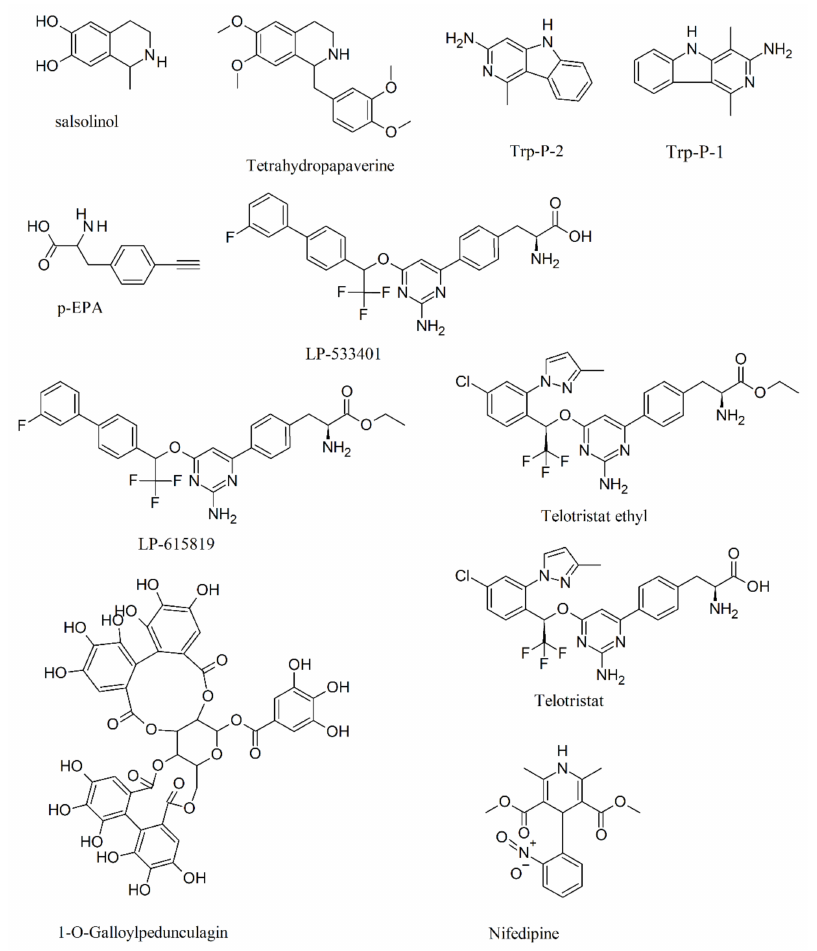
Figure 5. Structure formulae of some TPH